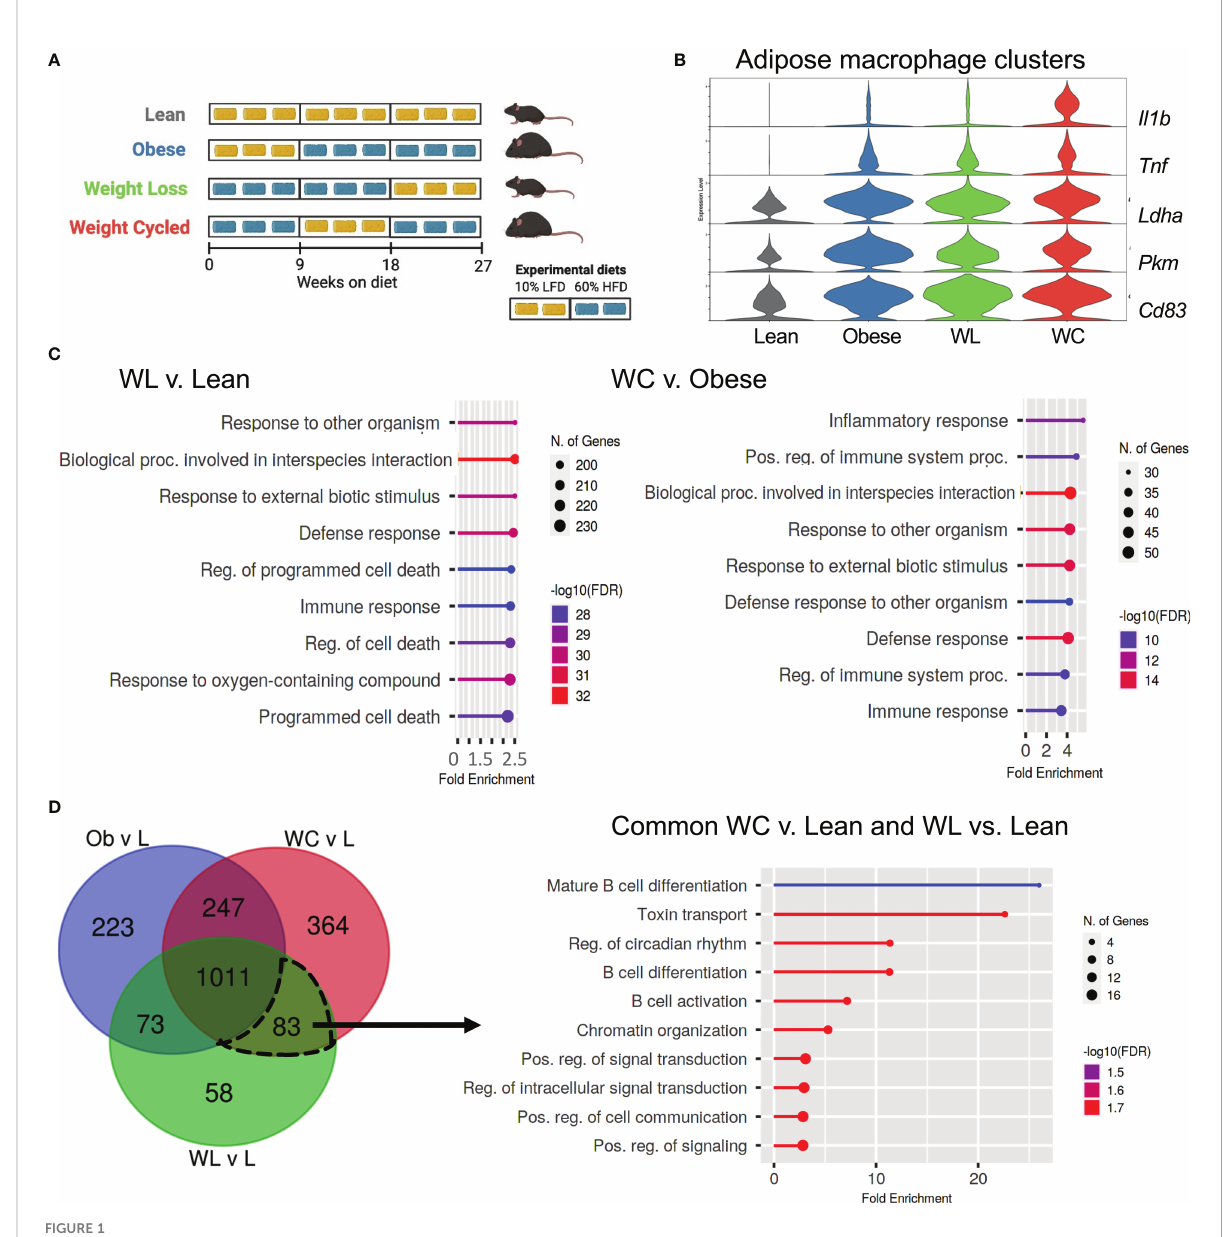
FIGURE 1 Transcriptional changes in adipose macrophages from weight loss (WL) and weight cycled (WC) mice suggest innate immune memory. (A) Weight cycling schematic. (B) Violin plot of in fl ammatory ( Tnf, Il1b, Cd83 ) and metabolic genes ( Ldha, Pkm ) from lean, obese, weight loss (WL), and weight cycled (WC) macrophage clusters. (C) Pathway analysis of differentially expressed genes from WC vs. obese or WL vs. lean macrophage clusters. (D) Venn diagram of differentially expressed genes of obese, WL, and WC adipose macrophage clusters compared with lean and pathway analysis of the genes differentially expressed in both WL and WC